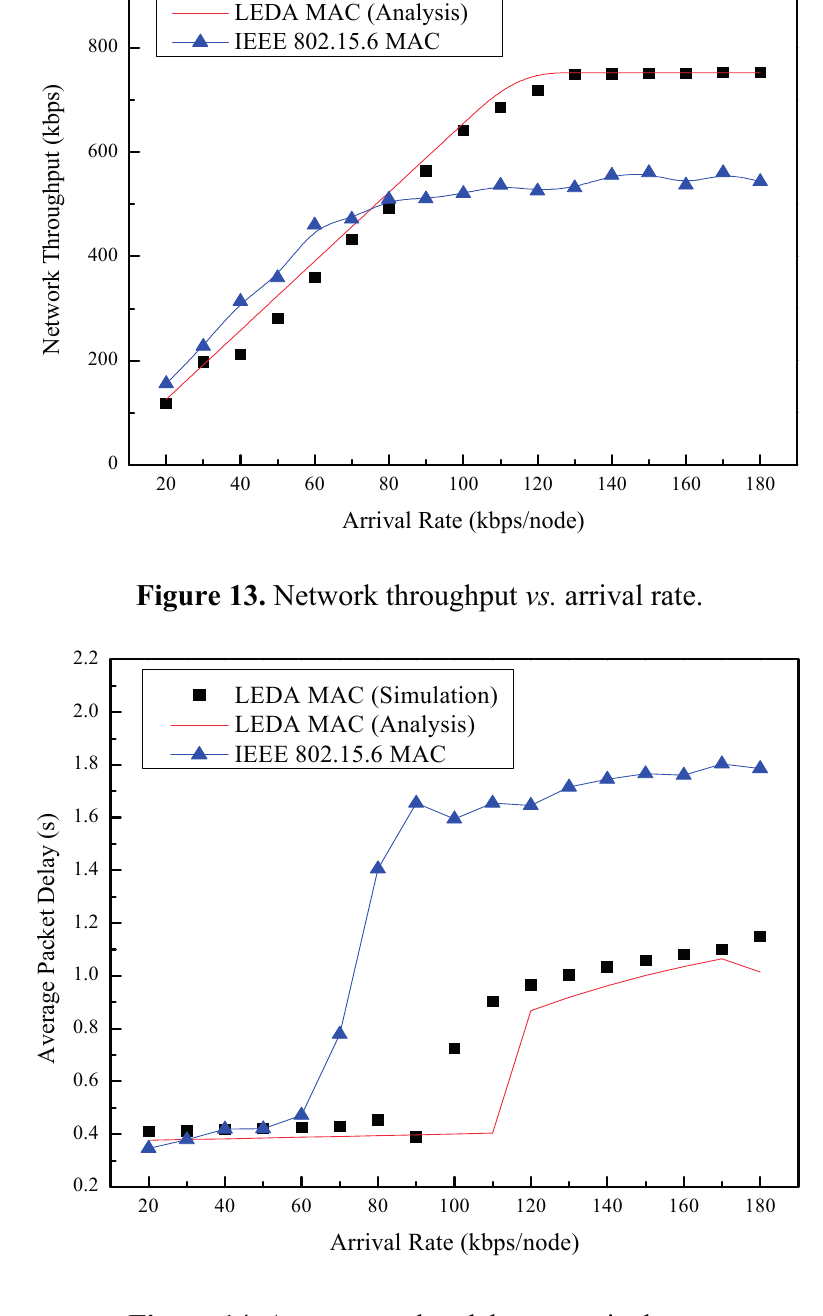
Figure 14. Average packet delay vs. arrival